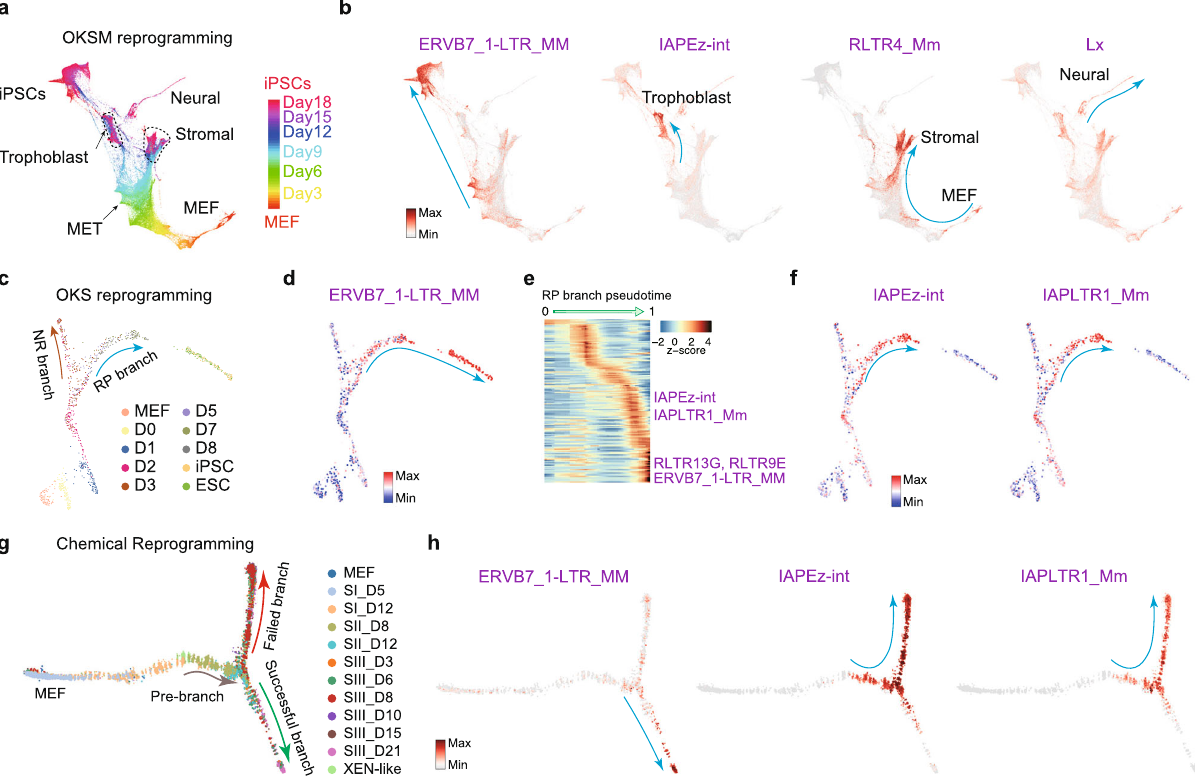
Fig. 5 Stage-speci fi c expression of TEs in somatic cell reprogramming. a Trajectory reconstruction during OKSM reprogramming, cells are colored by time point. b As in ( a ), but cells are colored by the expression of the indicated TEs. c Force-directed (FR) layout of cells during OKS reprogramming, cells are colored by time point. d Same with ( c ), but cells are colored by the expression change of the ERVB7_1-LTR_MM TE during reprogramming. e Expression heatmap of the top 145 dynamically expressed TEs in a pseudotime ordering for the RP branch, selected TEs are indicated. f Expression changes of the indicated TEs during reprogramming. g Trajectory reconstruction during chemical reprogramming, cells are colored by time point. h As in ( g ), but showing TE expression speci fi c to the successful or failed branches of